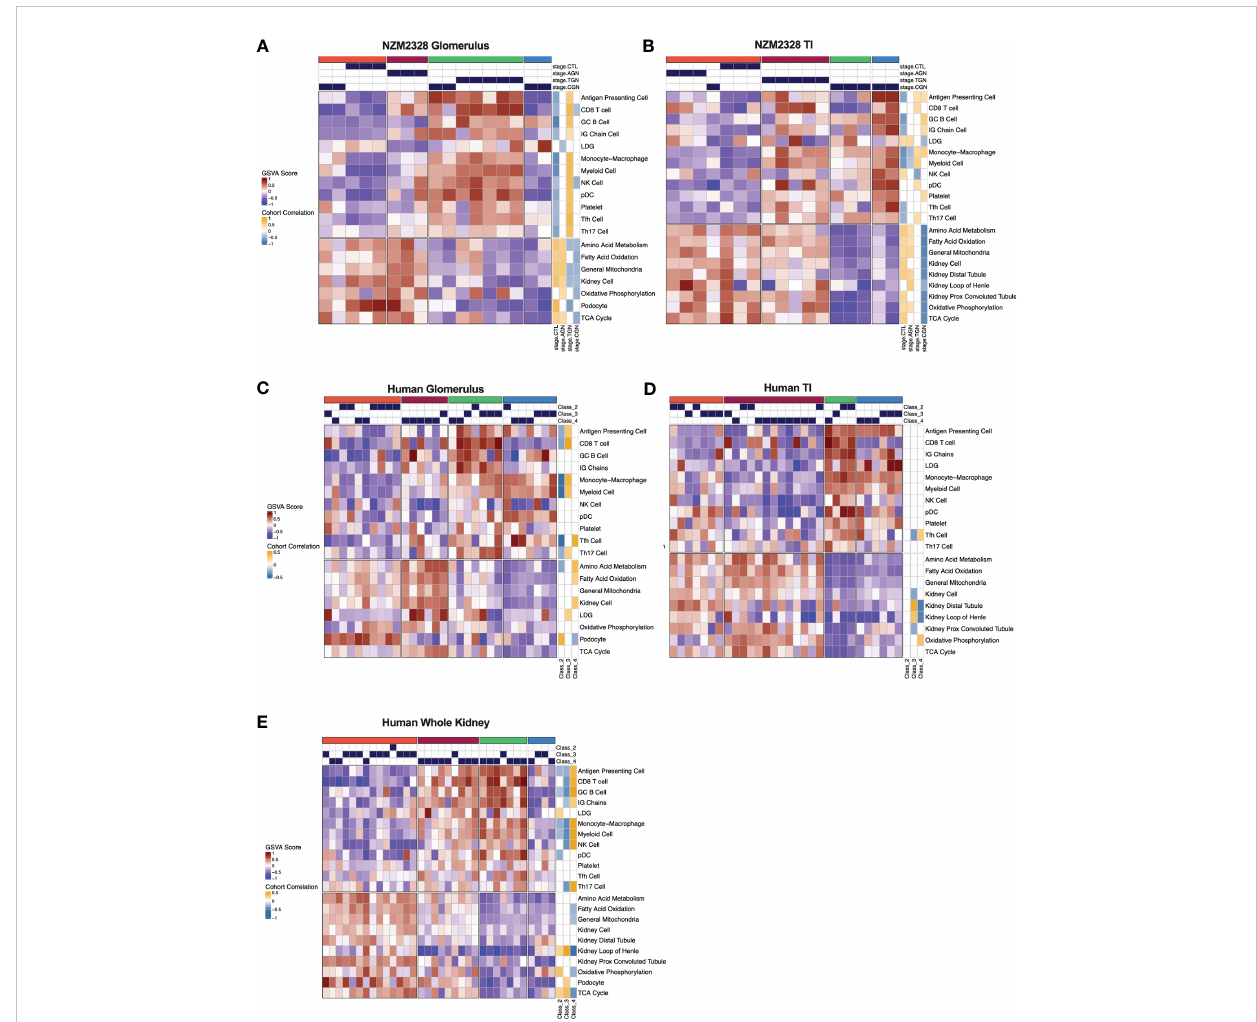
FIGURE 7 Gene signature-based clustering of GN stages in NZM2328 mice translates to human LN patients. (A, B) K-means clustering (k=4) of NZM2328 CTL, AGN, TGN, and CGN mouse glomeruli (A) and TI (B) based on GSVA enrichment scores of selected immune cell, kidney cell, and metabolic pathway gene sets. (C-E) K-means clustering (k=4) of microdissected glomeruli (C) , TI (D) , and whole kidney (E) from human LN patients based on GSVA score from human orthologs of the mouse gene sets used in (A, B) . Heatmap visualizations depict positive to negative GSVA scores on a red to blue gradient and positive to negative correlations between GSVA scores and disease classi fi cation on a gold to blue